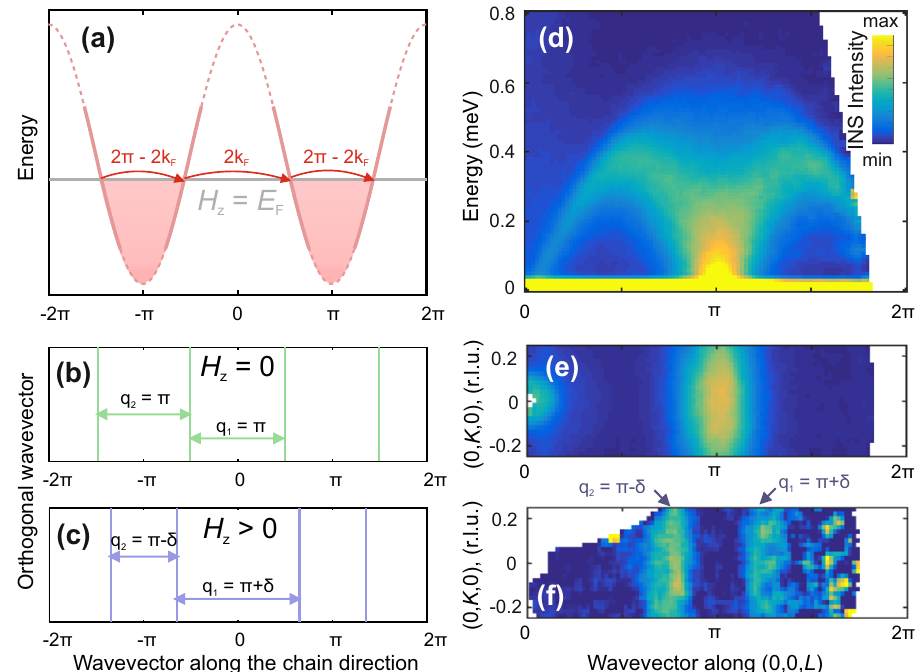
Fig. 1 Bandstructure of fermions in the Heisenberg chain and its manifestations in the INS spectrum of YbAlO 3 . a Red line shows the bandstructure in the fermionic representation for a Heisenberg spin chain. Part of the curve is dotted to indicate that the linearization is strictly valid only in the vicinity of the chemical potential. The horizontal gray line shows the positions of the fi eld-dependent chemical potential, E F = H z ; the red shaded area shows the occupied part of the fermionic band. 1D Fermi surfaces for H z = 0 and H z > 0 are shown by vertical lines in b and c , respectively. Arrows in b , c indicate the wavevectors of the 2 k F Kohn instability. d Inelastic neutron scattering (INS) spectrum of YbAlO 3 collected at T = 1 K, B = 0 T (1D regime of decoupled chains), showing the spinon continuum. e , f Constant-energy slices in the (0 KL ) scattering plane measured at T = 1 K, B = 0 T ( e ); T = 0.05 K, B = 0.6 T ( f ). The signal is integrated just above the elastic line, over the interval ħ ω = [0.05 − 0.1] meV. The INS signal shows stripes at the wavevector of the Kohn anomaly, q = π at B = 0 and q = π ± δ at B = 0.6